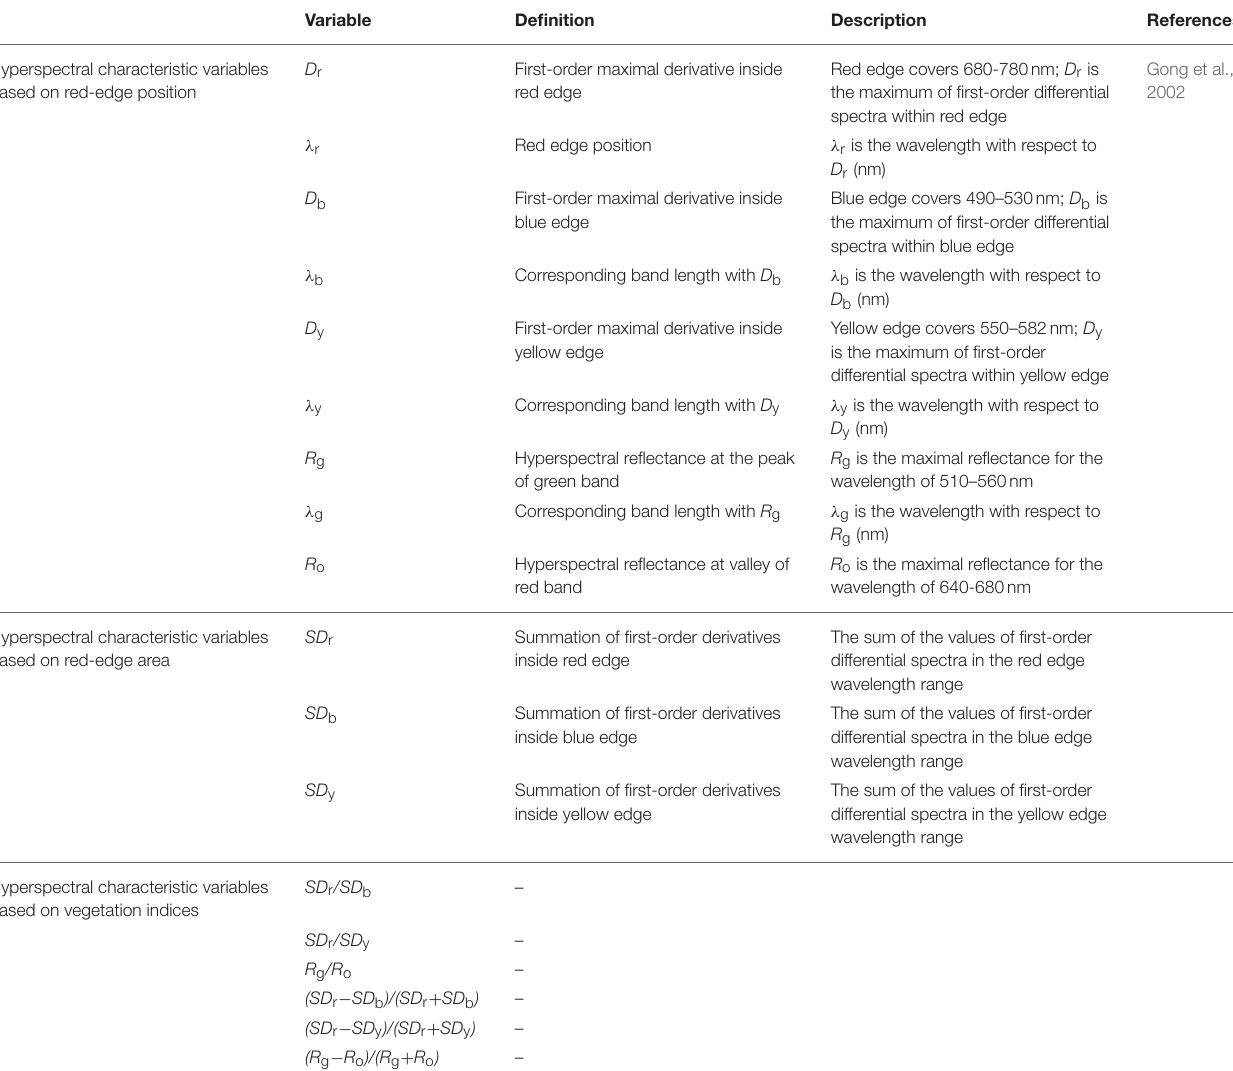
TABLE 1 | Definitions of hyperspectral remote sensing parameters used in the